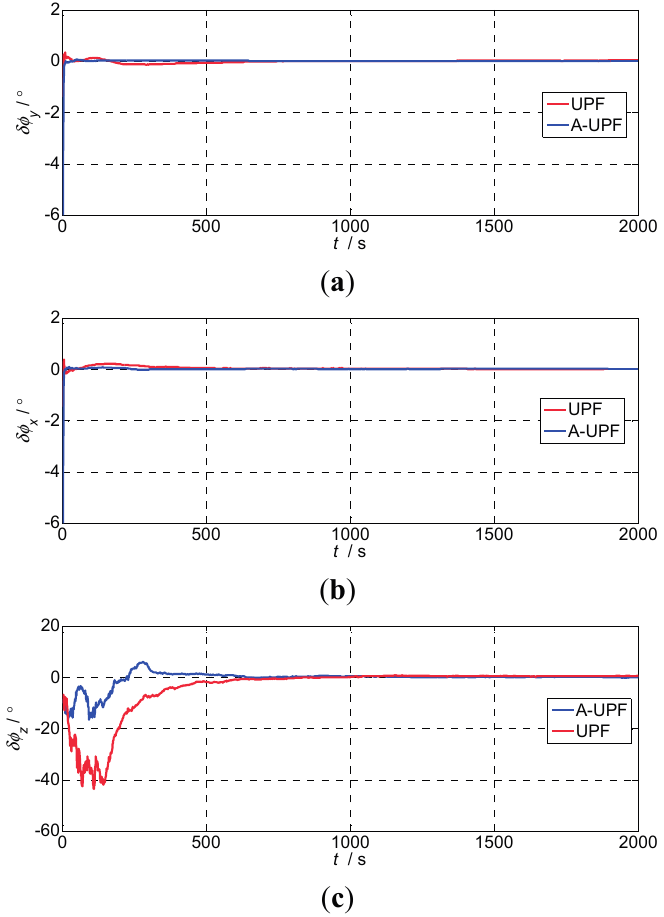
Figure 6 . Estimation error curves for misalignment angles: ( a ) Pitch errors; ( b ) Roll errors; ( c ) Heading